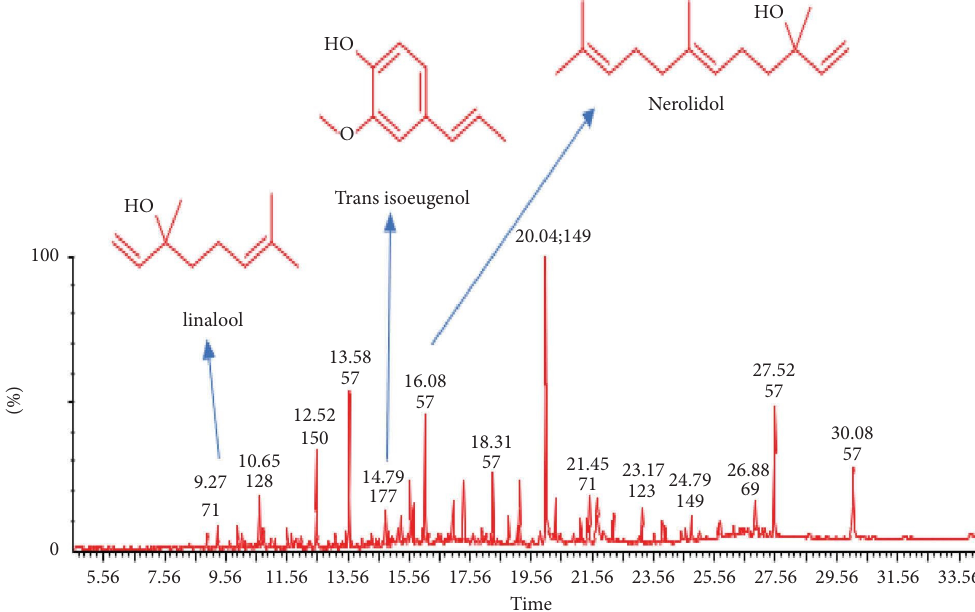
Figure 2: Total ion chromatogram (TIC) obtained from the GC-MS run of the leaf essential oil of Vitex doniana. Compounds were identifed by comparison of MS spectra data with the NISTand Wiley libraries. Chemical structures of some of the compounds are shown and were drawn with